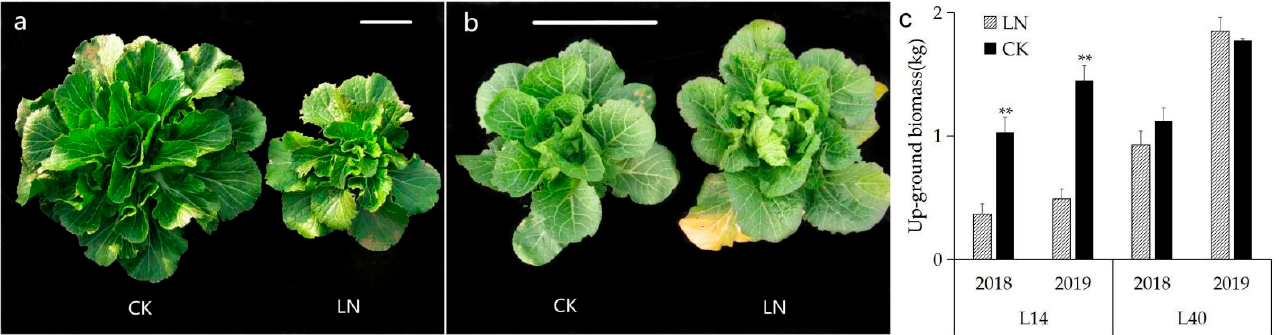
Figure 1. L14 and L40 under different N supply levels in the field. ( a ), L14 under CK and LN conditions. Bar = 5 cm; ( b ), L40 under CK and LN conditions. Bar = 5 cm; ( c ), up-ground biomass (UBM) of Chinese cabbage varieties L14 and L40 under different N supply conditions in the field; ** indicates significant differences at the level of 0.01 according to t